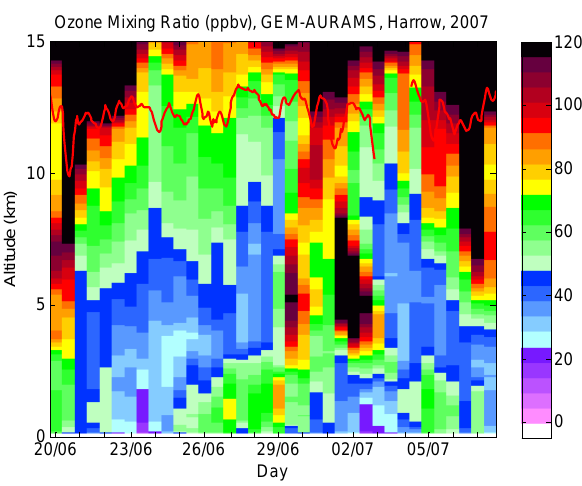
Figure 6: Vertical ozone profiles from GEM-AURAMS, at Harrow during the BAQS-Met Fig. 6. Vertical ozone profiles from GEM-AURAMS, at Harrow campaign. The white solid line shows the radar-derived tropopause. Date and time are UTC. during the BAQS-Met campaign. The red solid line shows the radar- derived tropopause. Date and time are UTC.